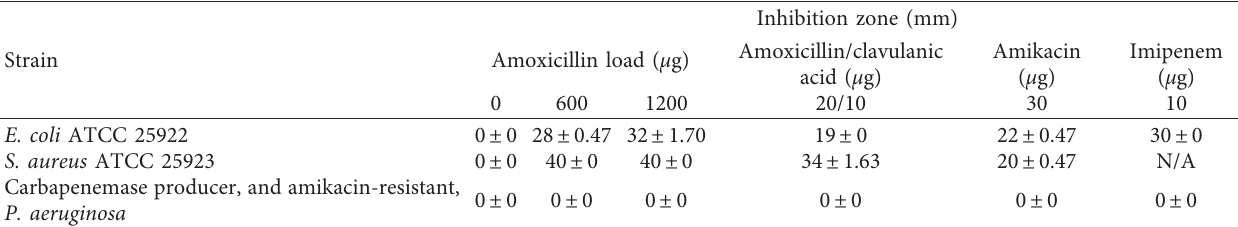
Values are presented as means ± standard